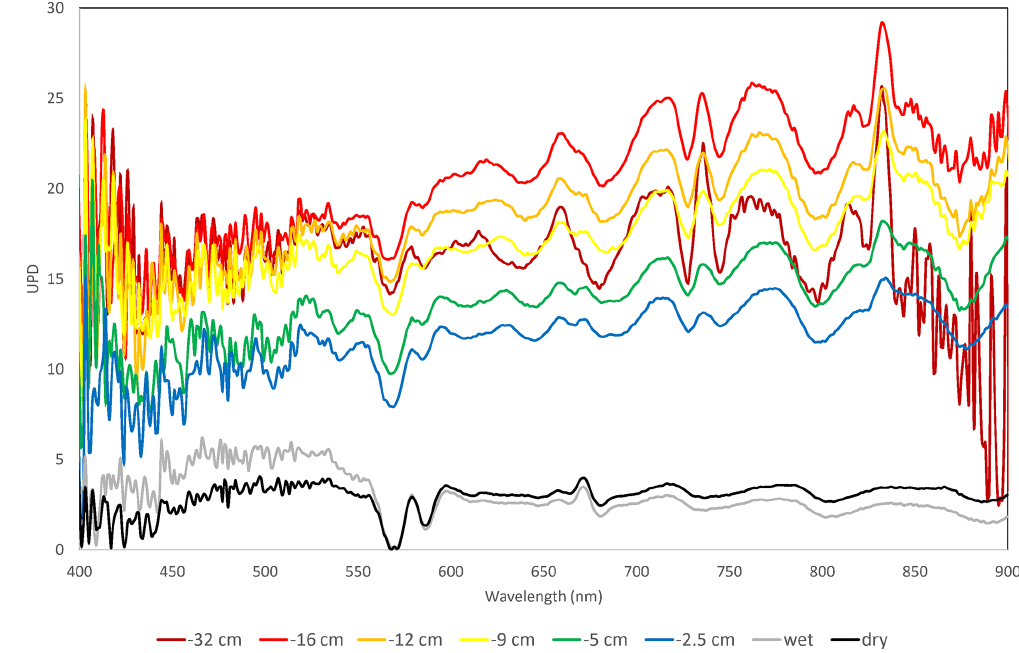
Figure 14. Unbiased percentage difference (UPD) for the orange place mat, measured at different